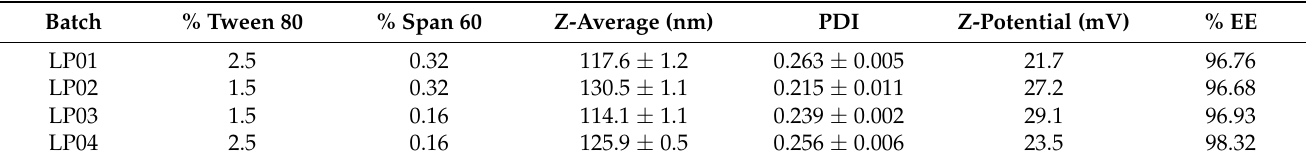
Table 4. Influence of Span 60 and Tween 80 on the physicochemical parameters.